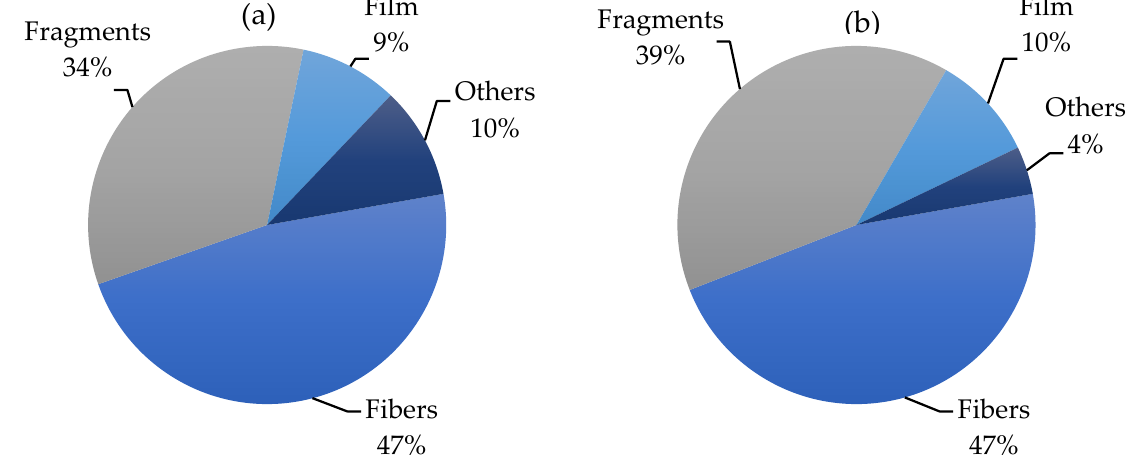
Figure 2. Pie charts showing the relative abundance (%) of fibers, fragments, films and other shapes (i.e., spheres, pellets, sheets) in the literature data globally in biota ( a ) and water ( b ) from the Mediterranean Sea.